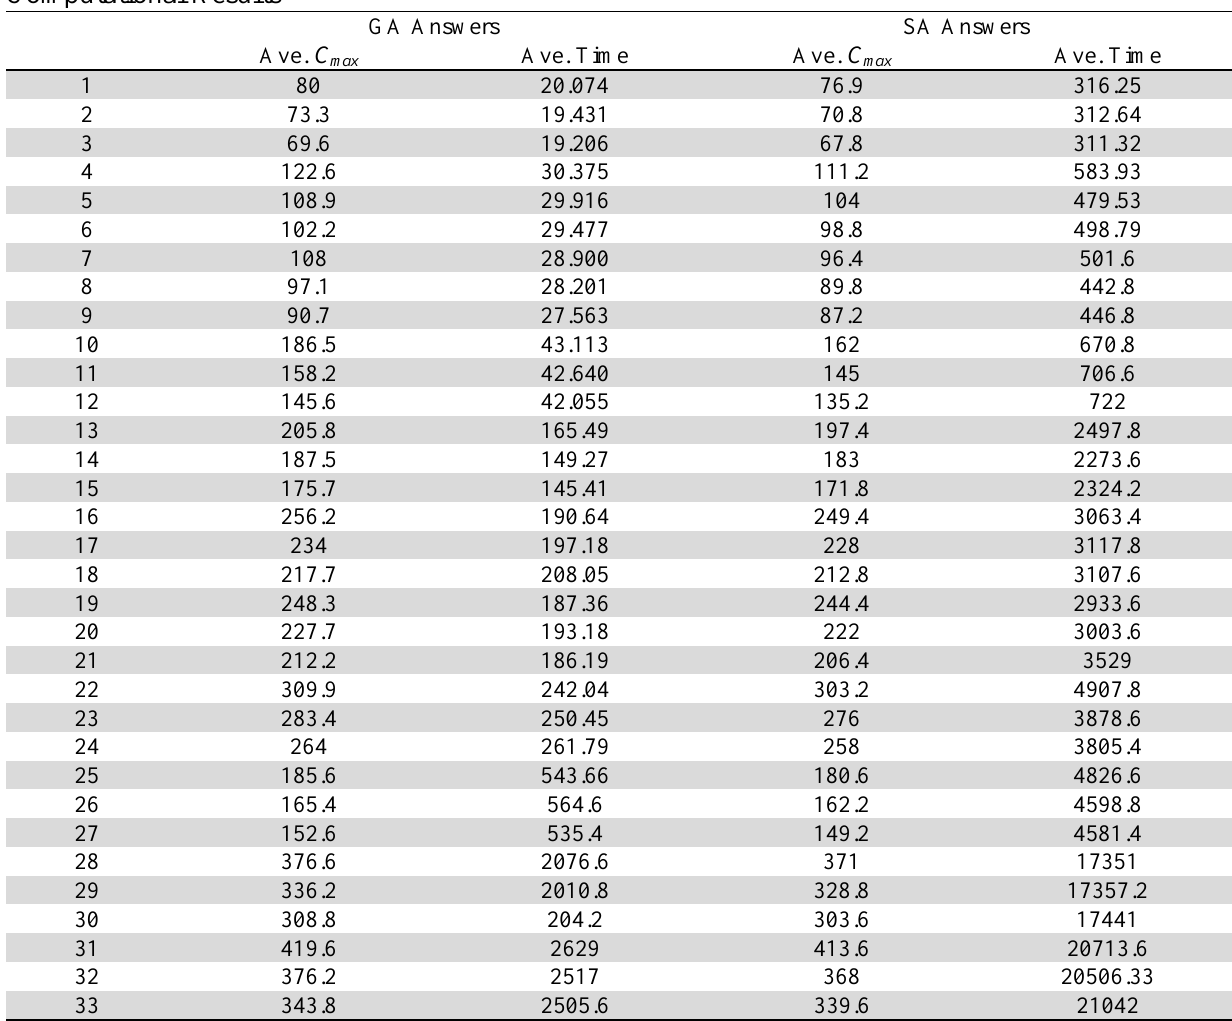
Computational Results